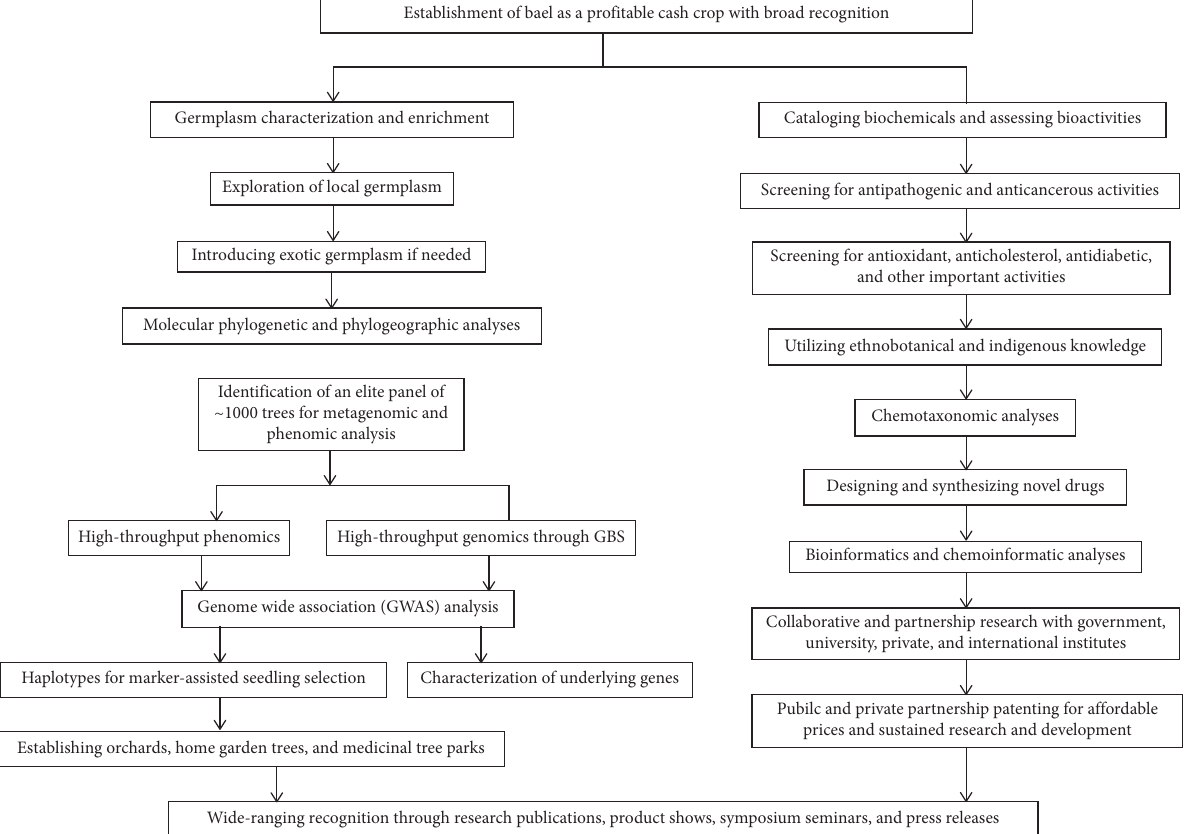
Figure 1: The proposed genomics, phenomic- and biochemical-based industrial strategies to develop bael as a recognized cash